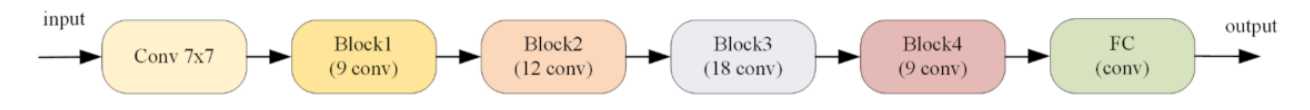
Figure 4. Residual block structure of ResNet50.